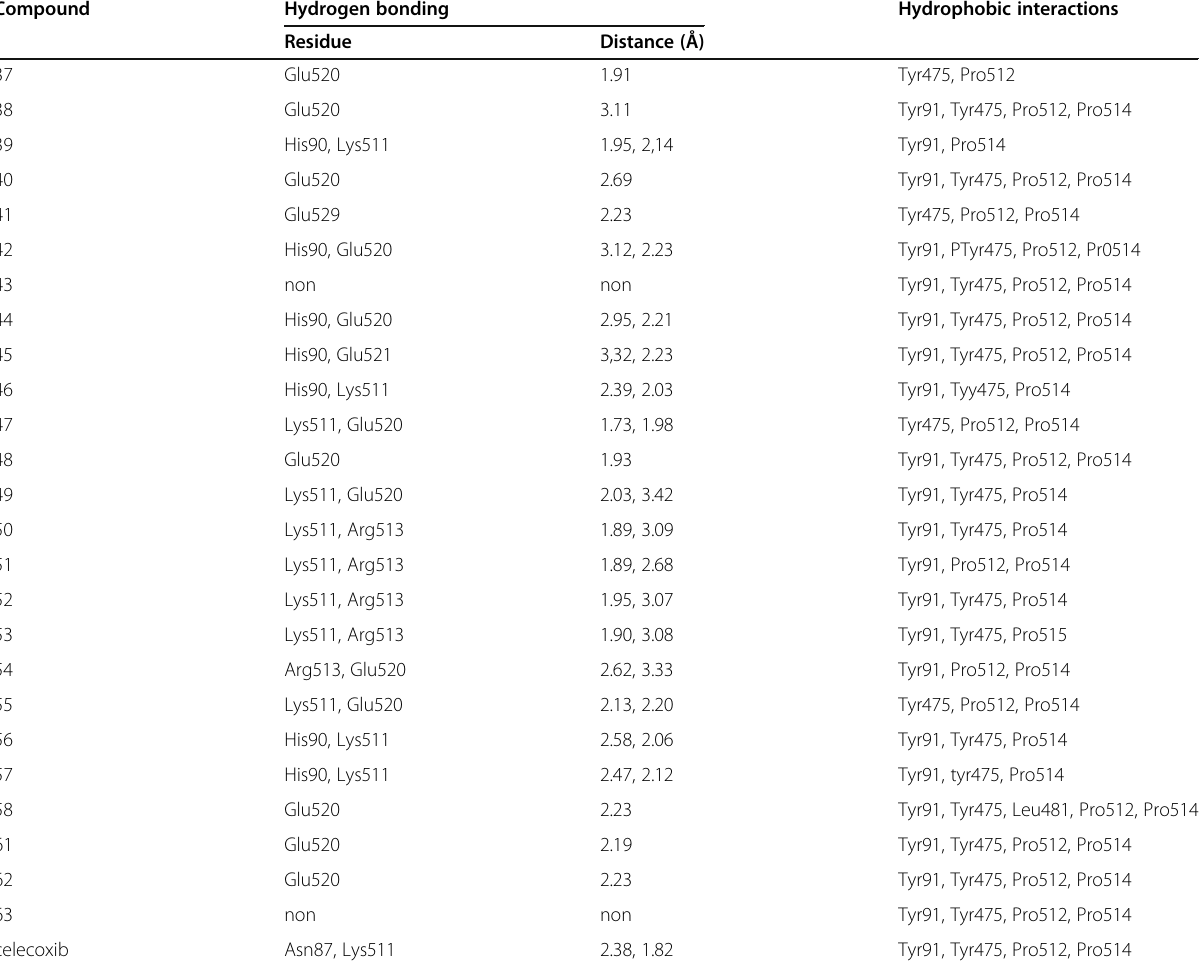
Table 4 Hydrogen bonding and hydrophobic interactions of sydnones 37 – 58 and 61 – 63 and celecoxib with COX-2 binding site